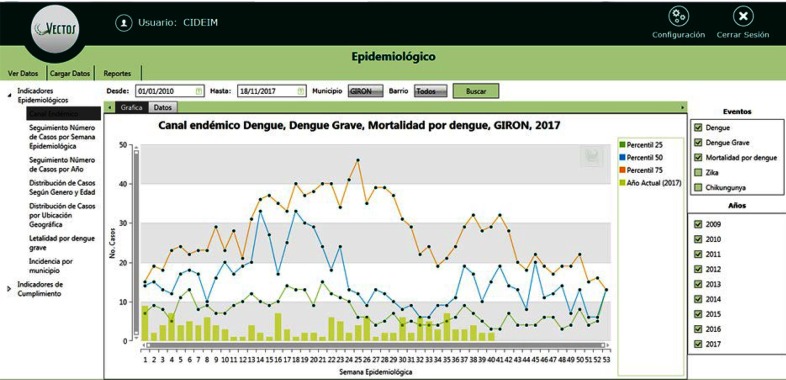
VECTOS Graphical Report of Epidemiological IndicatorsThis example shows actual data from the municipality of Giron in 2017. More specifically, the dengue endemic channel is indicated by the lines, which are percentiles of case numbers, from January 1, 2010, to November 18, 2016. Bars show the contemporaneous data for 2017.